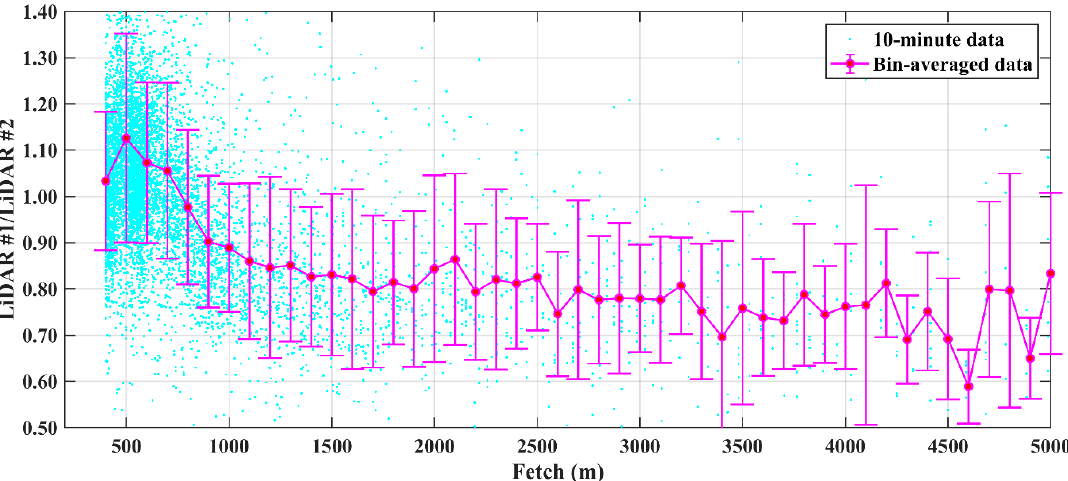
Figure 13. Ratios of turbulence intensity between LiDAR #1 at 47 m and LiDAR #2 at 50 m ASL as a function of fetch length.